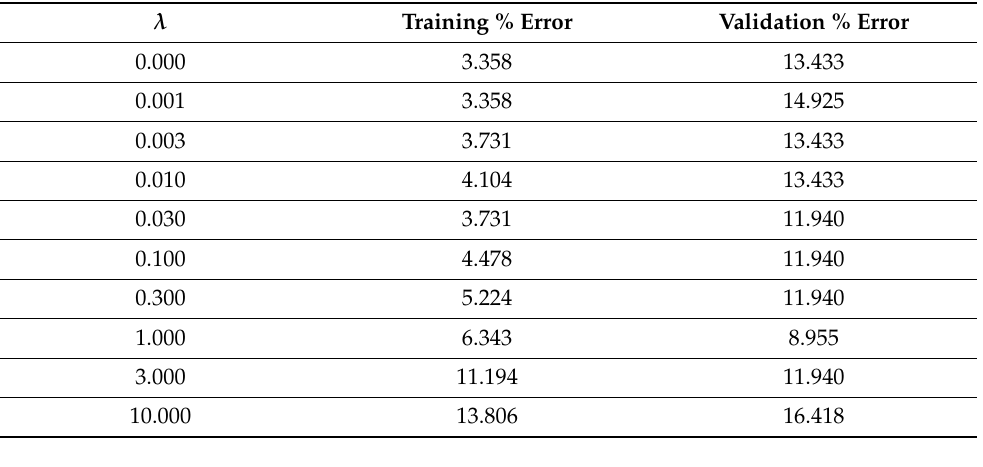
Table 7. Selection of the regularization parameter ( λ ) using cross validation samples.